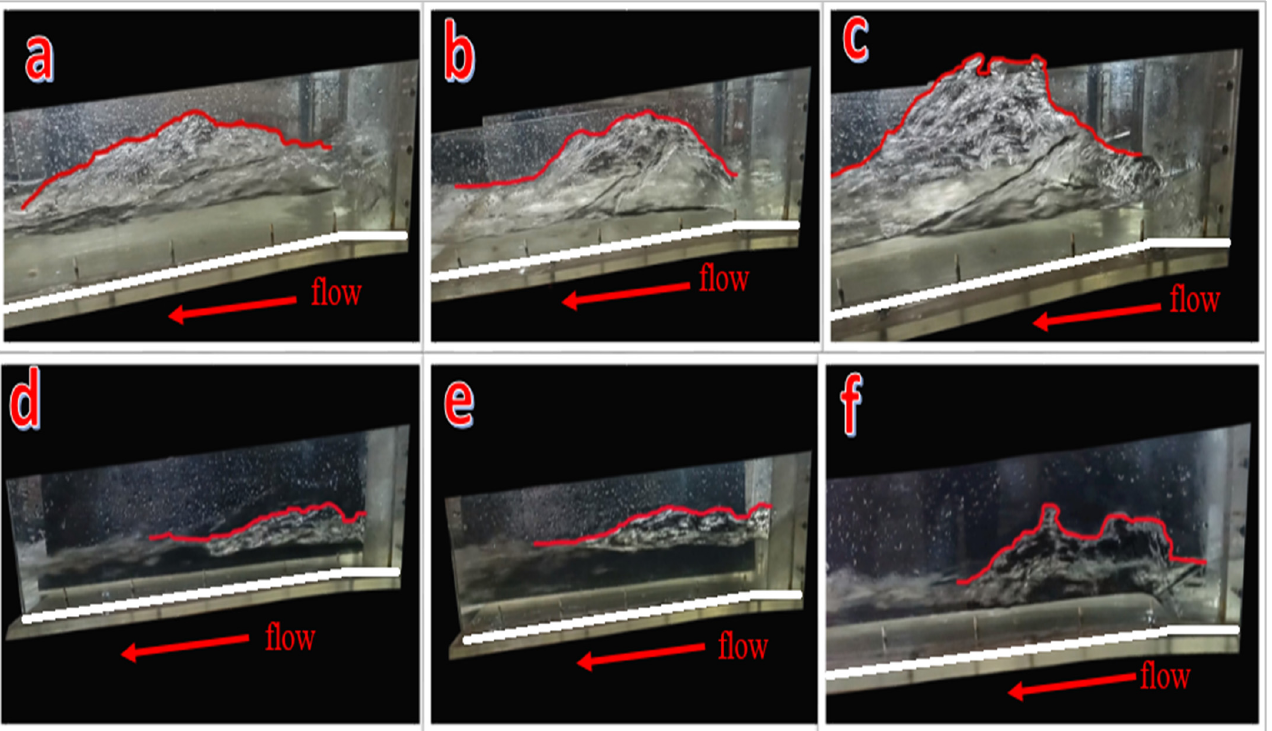
Figure 5. Profile views of shock wave formation for M 3 ( a–c ) and M 4 ( d–f ).